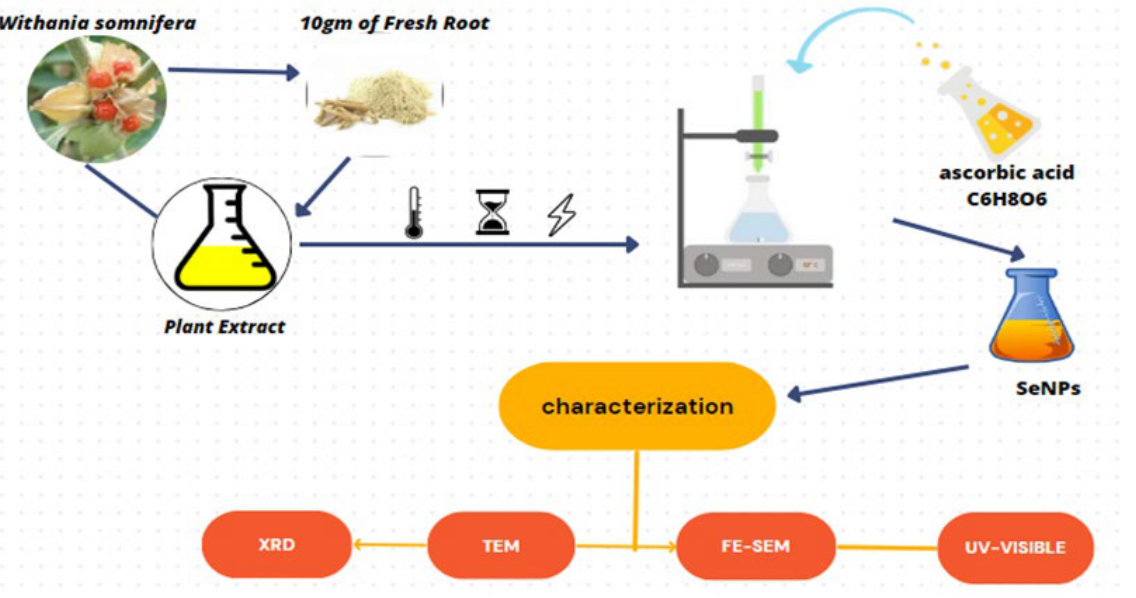
Figure 1. Steps of green synthesis method of silver nanoparticles using Withania Somnifera extract.